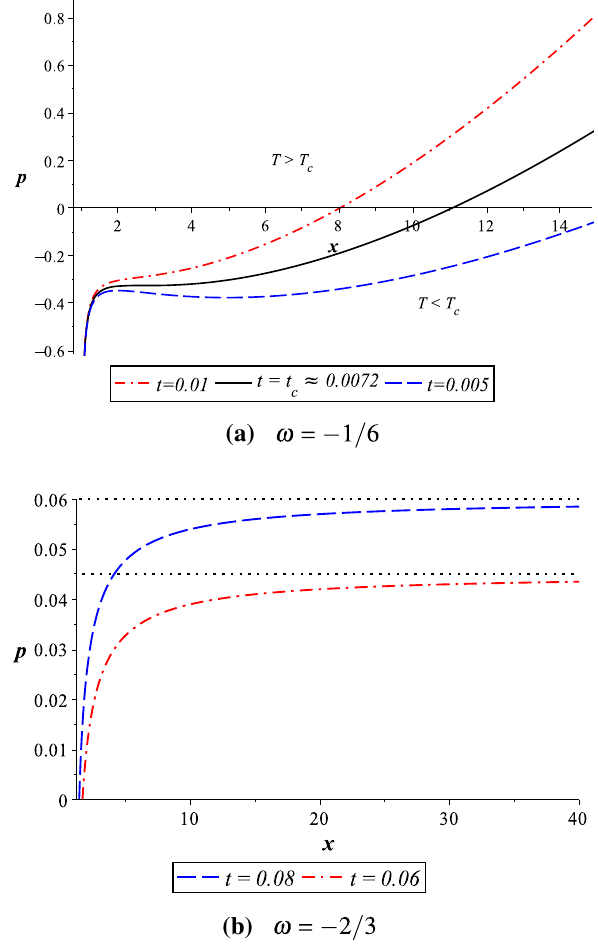
Fig. 3 p − x diagram for the cases ω = − 1 / 6 and ω = − 2 / 3. In these √ r + and V ∝ r 2 + , cases, V ∝